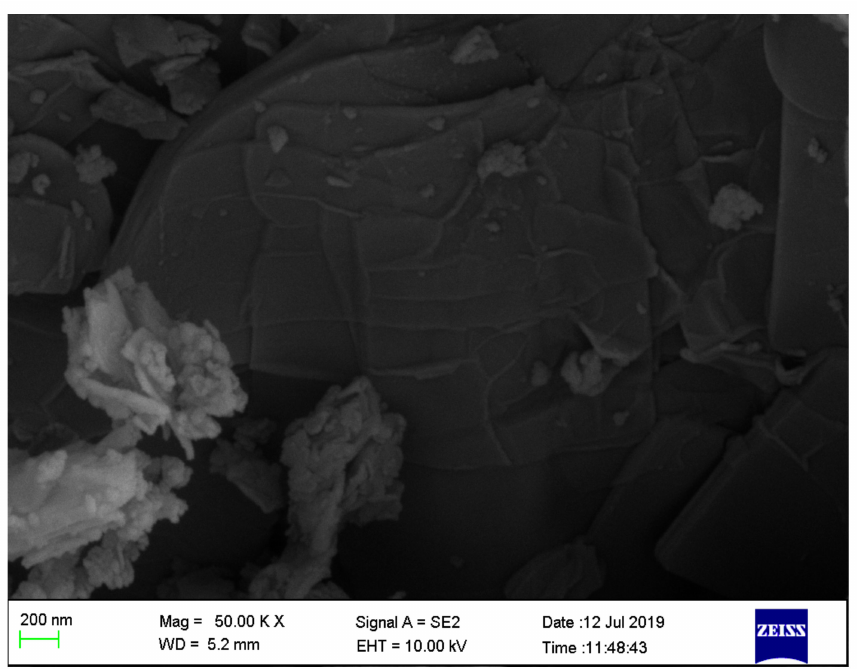
Figure 2. SEM image of silica sodalite.